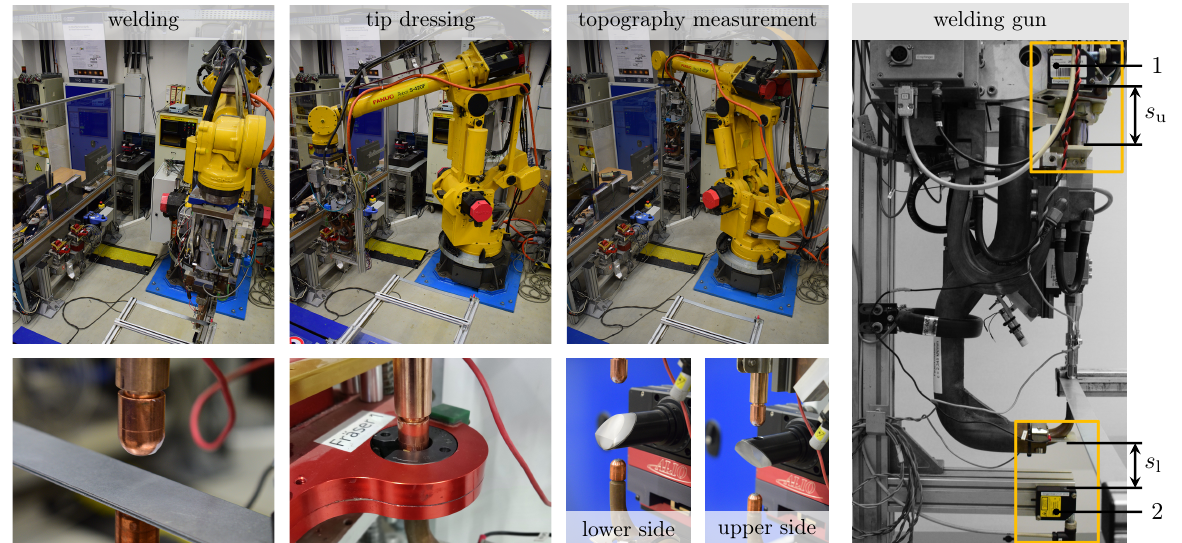
Figure 4. Experiment area for RSW for steel alloys at Technische Universität Dresden with welding gun positioned at all three modules for investigations in welding , tip-dressing, and topographical-measurement positions of upper and lower electrodes, and detailed view of welding gun with highlighted laser-triangulation sensors (1, 2) for measuring the displacement of upper electrode s u and lower electrode s l